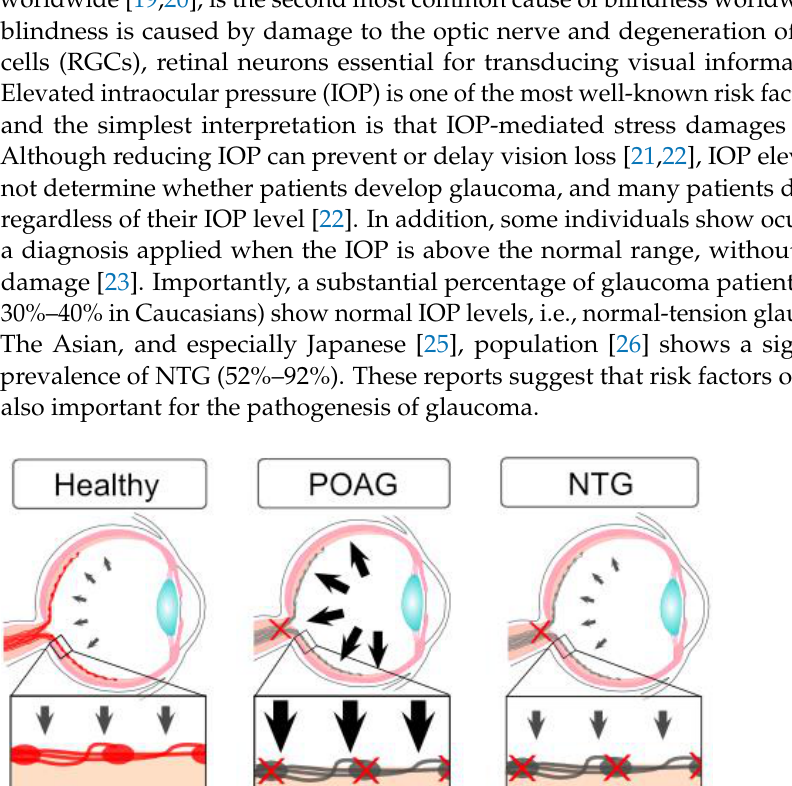
Figure 2. Cupping of the optic nerve head. In glaucoma patients, a central depression of the retina (i.e., the optic cup) is de- formed, leading to posterior displacement and enlargement of the optic cup. The lamina cribrosa, a collagen-enriched tissue, provides physical support to the retinal ganglion cell (RGC) axons. With the enlargement of the optic cup, the structural remodeling of the lam- ina cribrosa physically stresses and damages the optic nerve. The normal and neuropro- tective astrocytes support RGC axon integrity by releasing neurotrophic factors and/or